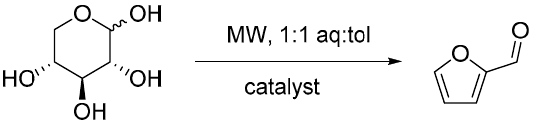
Scheme 1. General scheme for the catalytic production of furfural from xylose.